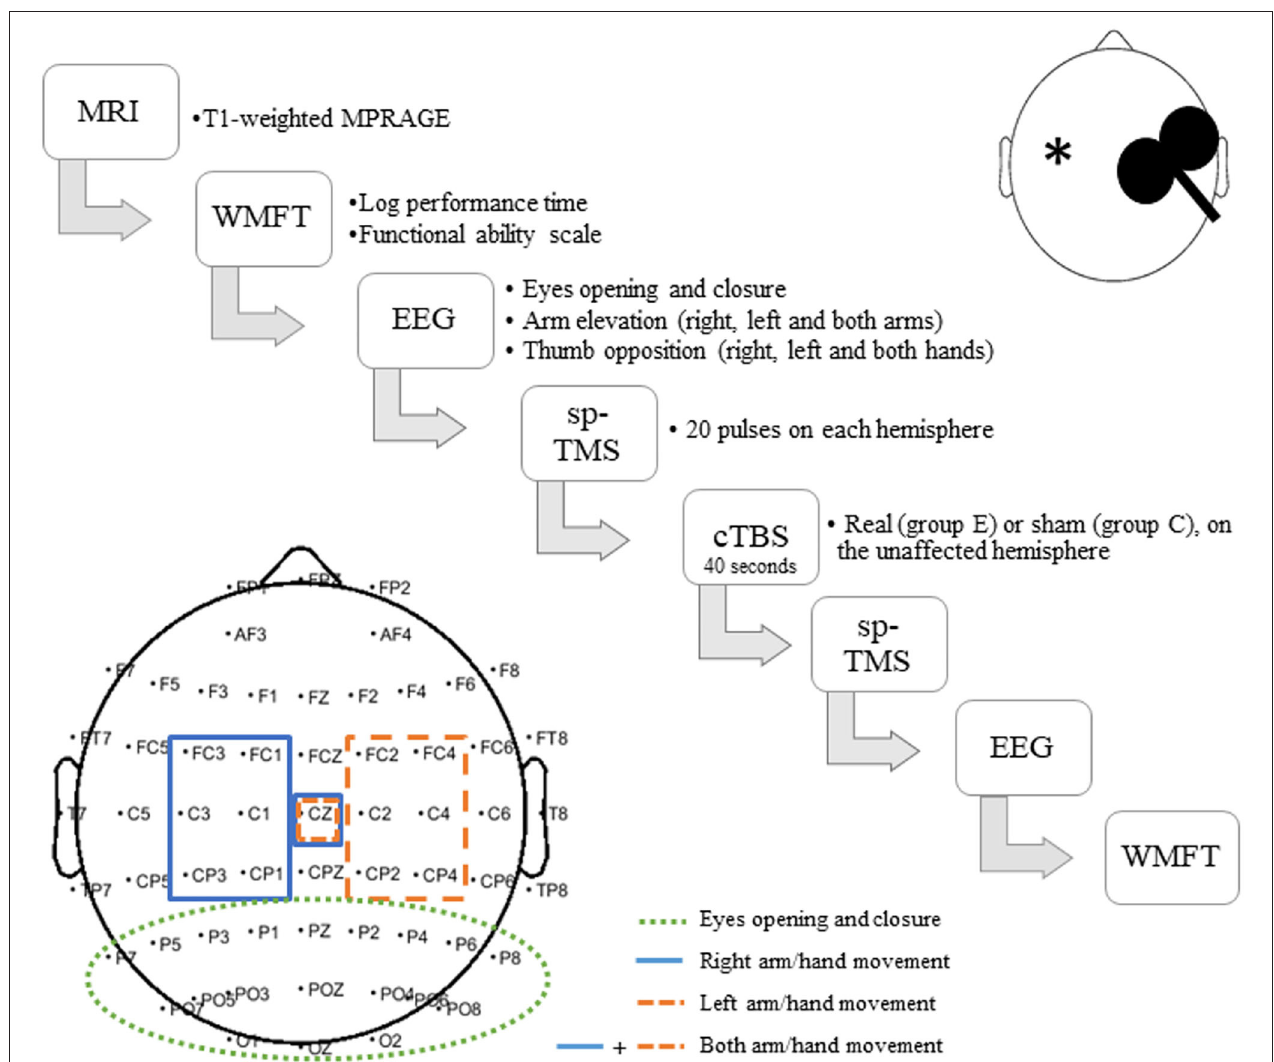
FIGURE 1 | Experimental design and procedures. Group E (Experimental) includes patients who received real stimulation, while in group C (Control) are those patients who received sham stimulation. *Represents the stroke lesion site, which could be either left- or right-sided.